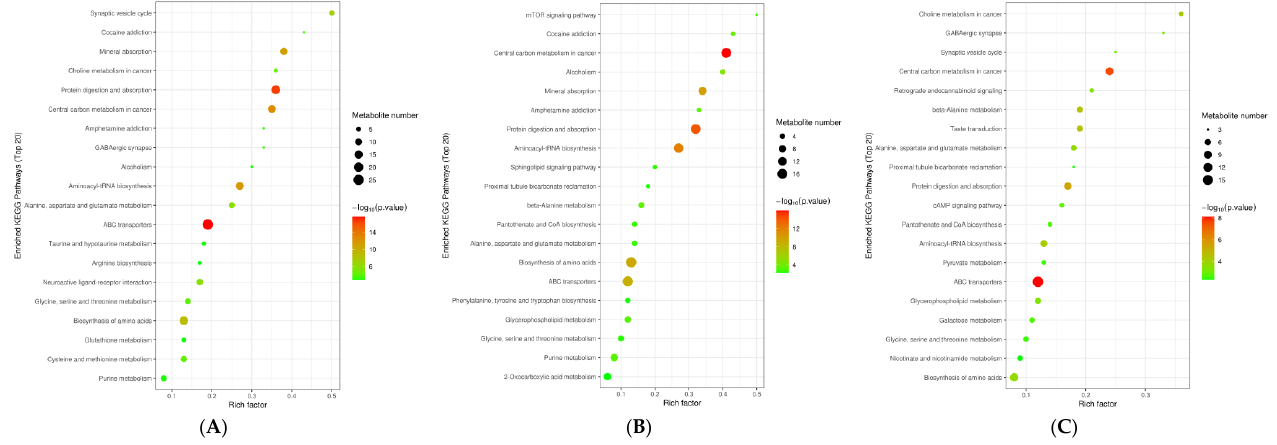
Figure 5. Top 20 enriched KEGG pathways of DFMs and possible pathways related to the fat metabolism in the liver: ( A ) GL16 vs. YL16; ( B ) YL16 vs. YL26; ( C ) GL16 vs. YL26. Rich factor = the ratio of the number of DFMs to total metabolites in each pathway; GL16 = non − castrated and slaughtered at 16 months of age; YL16 = castrated at birth and slaughtered at 16 months of age; YL26 = castrated at birth and slaughtered at 26 months of